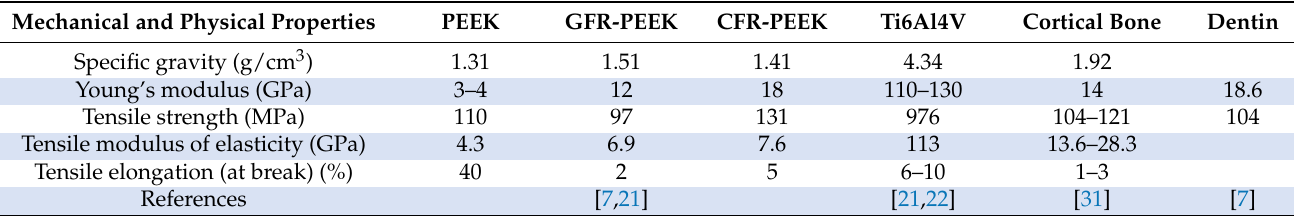
Table 1. The mechanical and physical